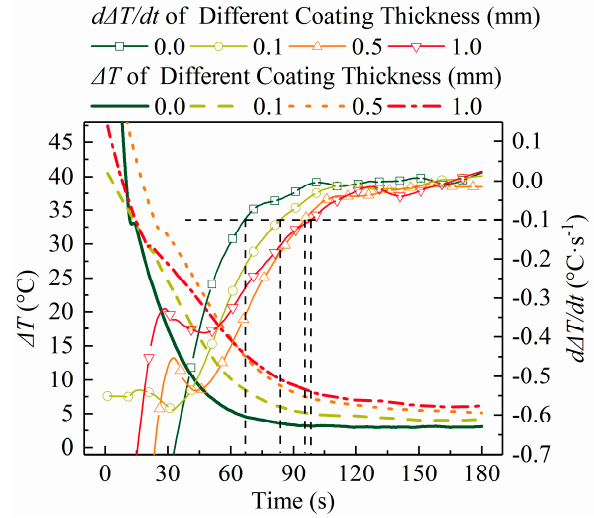
Figure 7. Temperature differences between slug center (Figure 5, point 1) and edge (Figure 5, point 4) and its differential with time. The dashed lines mark the end of the unstable stage.